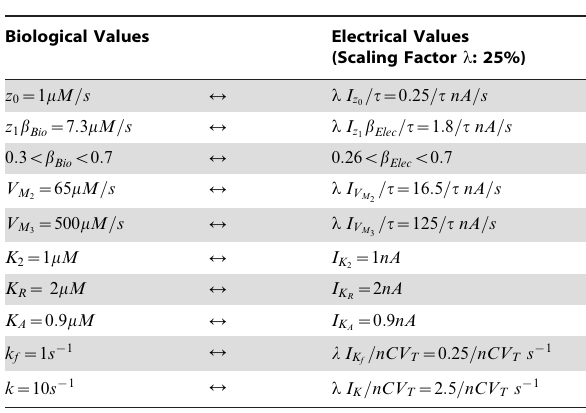
Table 8. Biological And Electrical Values For The Gene- Protein Regulatory Model (3D - Case) for E ~ 0 : 01